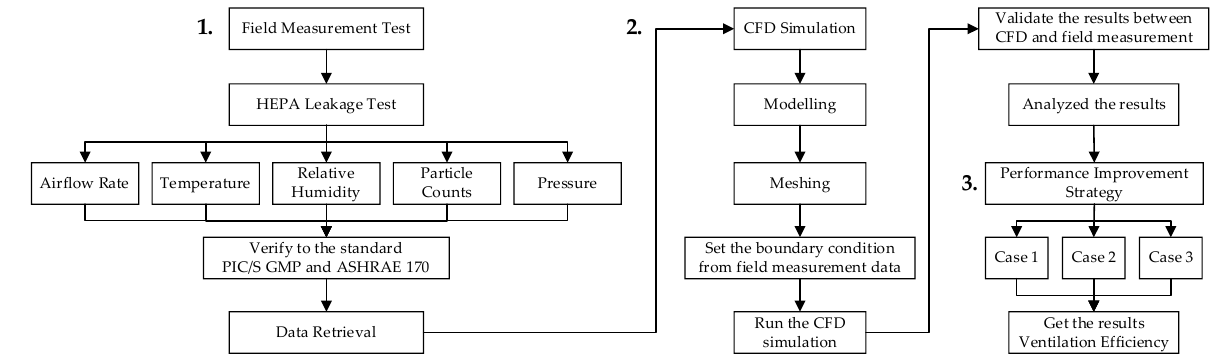
Figure 2. The proposed methodology framework.